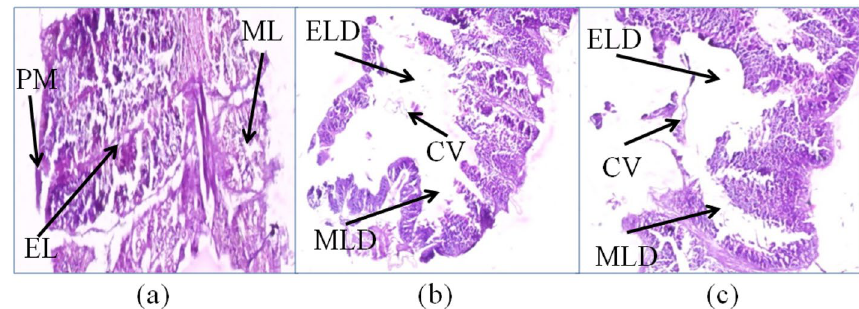
Figure 9. Longitudinal section through the midgut of 4th instar S. litura larvae ( a ) control larva fed on untreated diet, ( b ) larva fed on leaves treated with S. marcescens , ( c ) larva fed on leaves treated with E. mundtii . PM Peritrophic membrane, EL Epithelial layer, ML Muscle layer, ELD Epithelial layer disruption, CV Cytoplasmic vacuolization, MLD Muscle layer